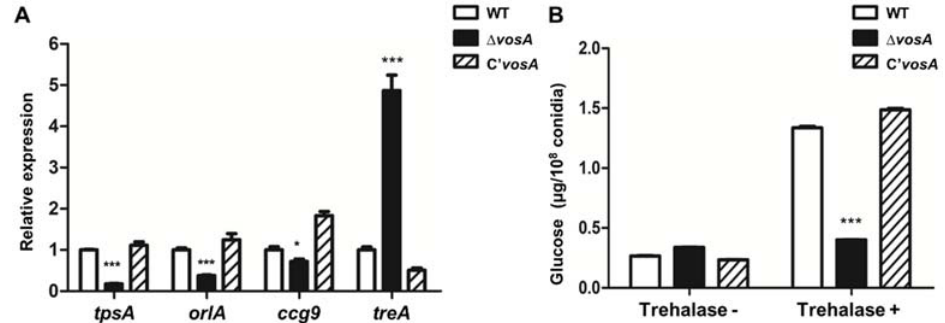
Figure 3. Trehalose biosynthesis in Δ vosA ascospores. ( A ) Levels of tpsA , orlA , ccg9 , and treA mRNA in WT (FGSC 4), Δ vosA (THS15.1), and C’ vosA (THS28.1) ascospores (WT vs. Δ vosA , *** p < 0.001). ( B ) The amount of glucose ( μ g) per 10 8 ascospores from 7 days cultures of cleistothecia from WT (FGSC 4), Δ vosA (THS15.1), and C’ vosA (THS28.1) strains (measured in triplicate). Trehalose is converted to D ‐ glucose by trehalase. The amount of glucose was assayed with a glucose assay kit. Untreated trehalase samples were used as negative controls (WT vs. Δ vosA , * p < 0.05; *** p < 0.001).